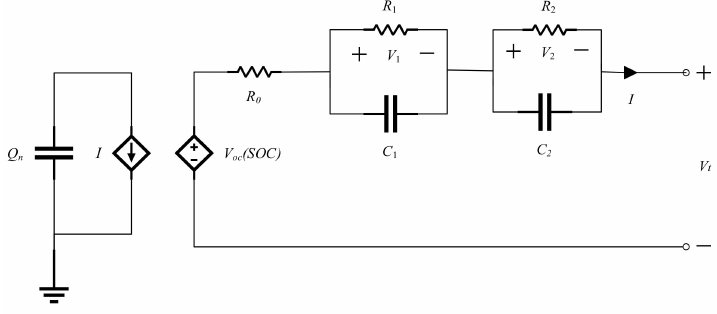
Figure 1. Second-order RC equivalent circuit